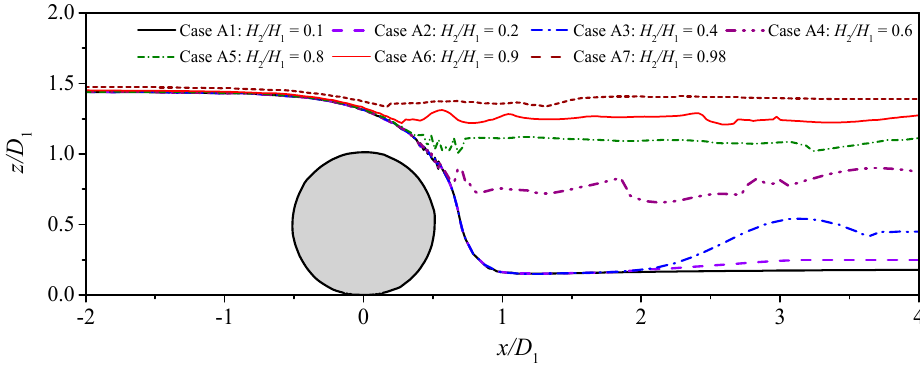
Figure 7. Variation of the water depths over the circular dam of different depth ratios for Cases A. Figure 8 illustrates the time-averaged velocity vectors on the mid-plane of the dam for three different depth ratios, H 2 /H 1 = 0.2, 0.6, and 0.98. The flow conditions distinctly differed when the water depth H 2 changed. When the depth ratio H 2 /H 1 = 0.2, there was a downward jet flow on the leeward side of the dam, and the downstream was a super- critical flow. In contrast, a submerged hydraulic jump (a high-speed flow near the channel bed and a reversed flow near the water surface) occurred in the wake of the dam when H 2 /H 1 = 0.6. When the depth ratio H 2 /H 1 = 0.98, the water flowed horizontally over the dam, and the high-speed flow stayed close to the free surface.